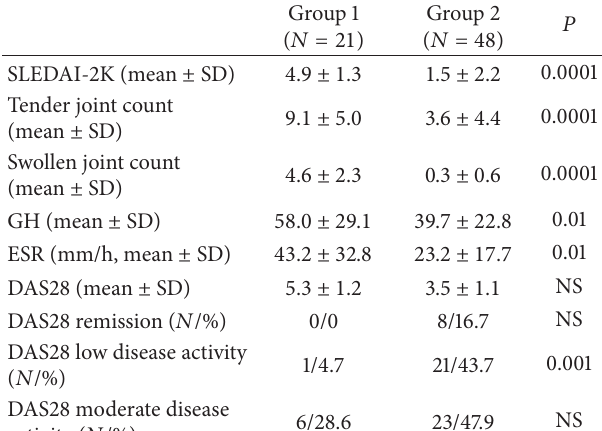
Table 3: Mean ± SD of DAS28 and its component in the SLE ( 𝑁 = 69 ) and RA patients ( 𝑁 = 44